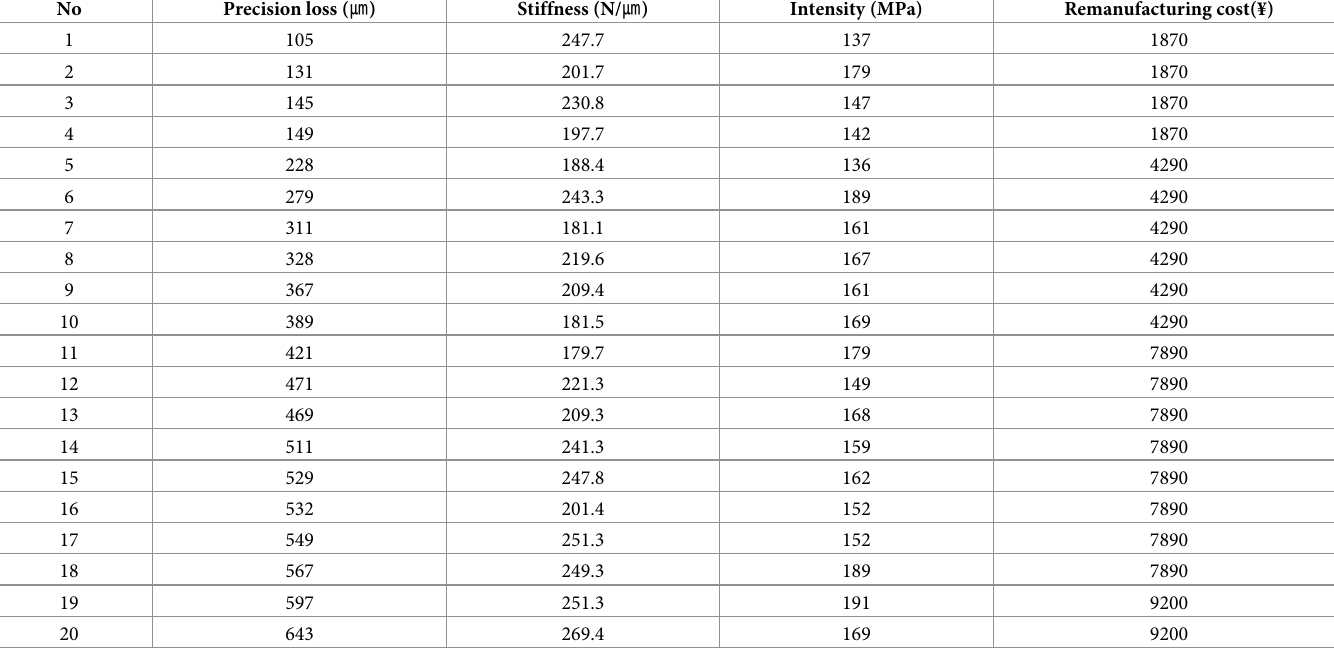
Table 2. ANN training samples